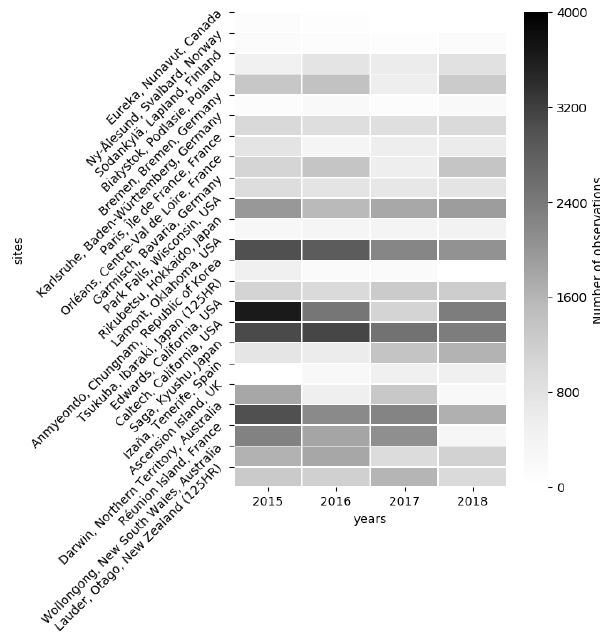
Figure 4. Number of TCCON observations for each site and